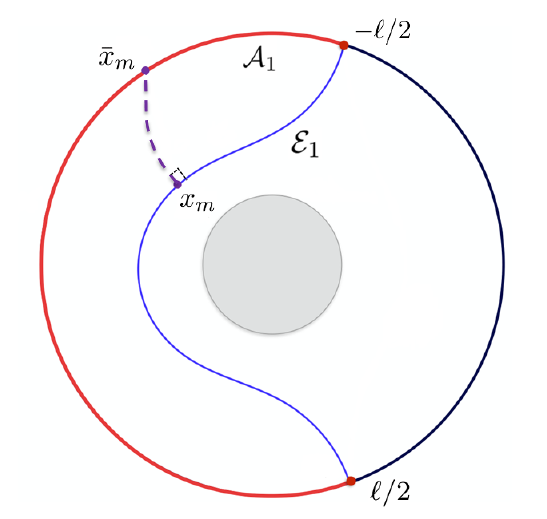
Figure 3 . The gray disk at the center represents the black hole. The dashed line represent the geodesics normal to E A which gives the (cid:12)ne correspondence between the points on A and the points on E A